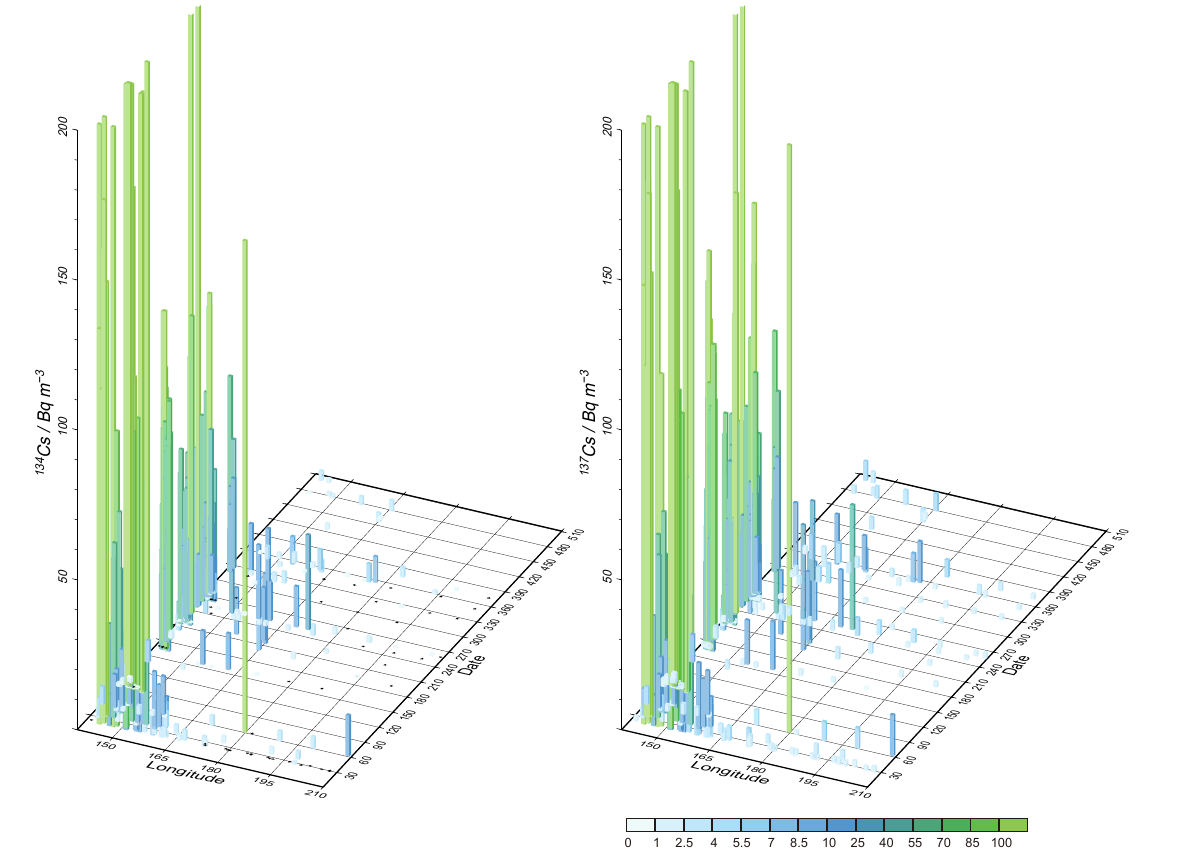
Fig. 5. 134 Cs (left) and 137 Cs (right) activity in the surface water during the period from 11 March 2011 (day 0) to 31 July 2011 (day 510) in the meridional zone of 38–42 ◦